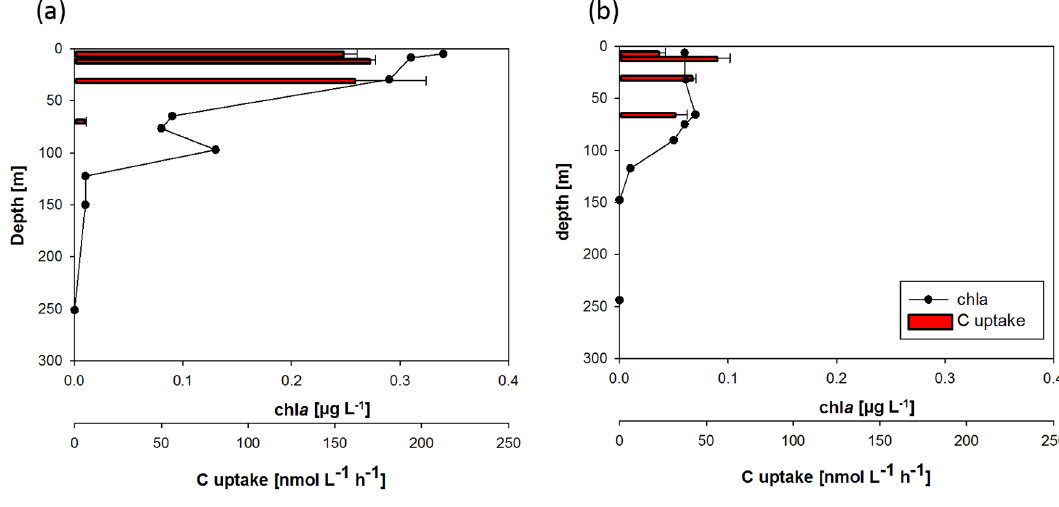
Figure 7. Chlorophyll a (chl a ,µg L − 1 ) distribution as determined from discrete measurements and carbon uptake rates (a) inside the eddy (eddy_2, second observation) and (b) at the eddy rim (location denoted in Fig. 1). Error bars indicate the standard deviation of three replicate samples for C